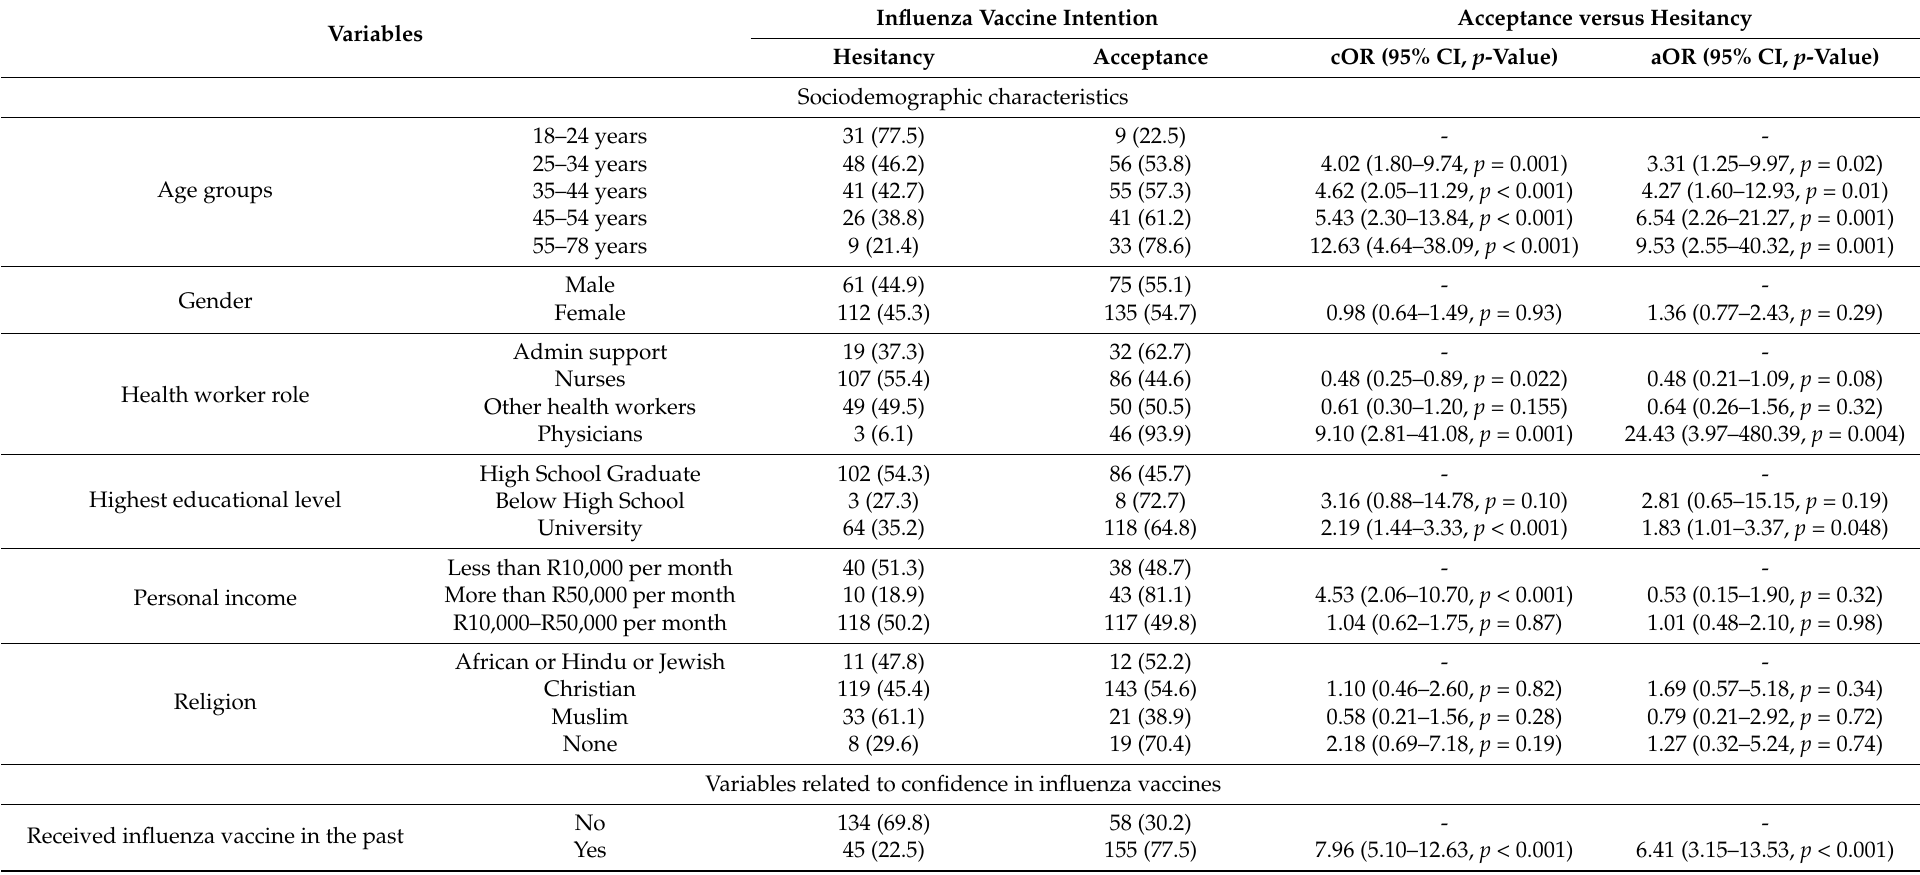
Table 3. Univariate and multivariable logistic regression analysis of factors associated with influenza vaccine acceptance (vs. hesitancy) among healthcare professionals at the start of COVID-19 vaccine rollout in Cape Town, South Africa. The table contains six different multivariable models (six subheadings), the first of which assesses sociodemographic factors (including religion), while the second through sixth models assess the effect of variables related to specific items pertaining to the 5C questionnaire components (i.e., confidence, complacency, constraint, calculation, and collective responsibility) that are independently associated with influenza vaccination